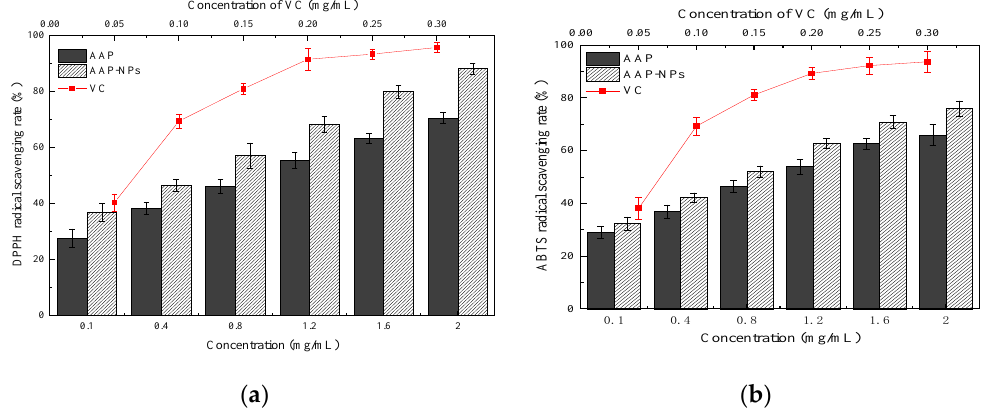
Figure 8. In vitro antioxidant activity of AAP-NPs, original AAP and VC, including ( a ) DPPH radical scavenging activity and ( b ) ABTS+ radical scavenging activity.